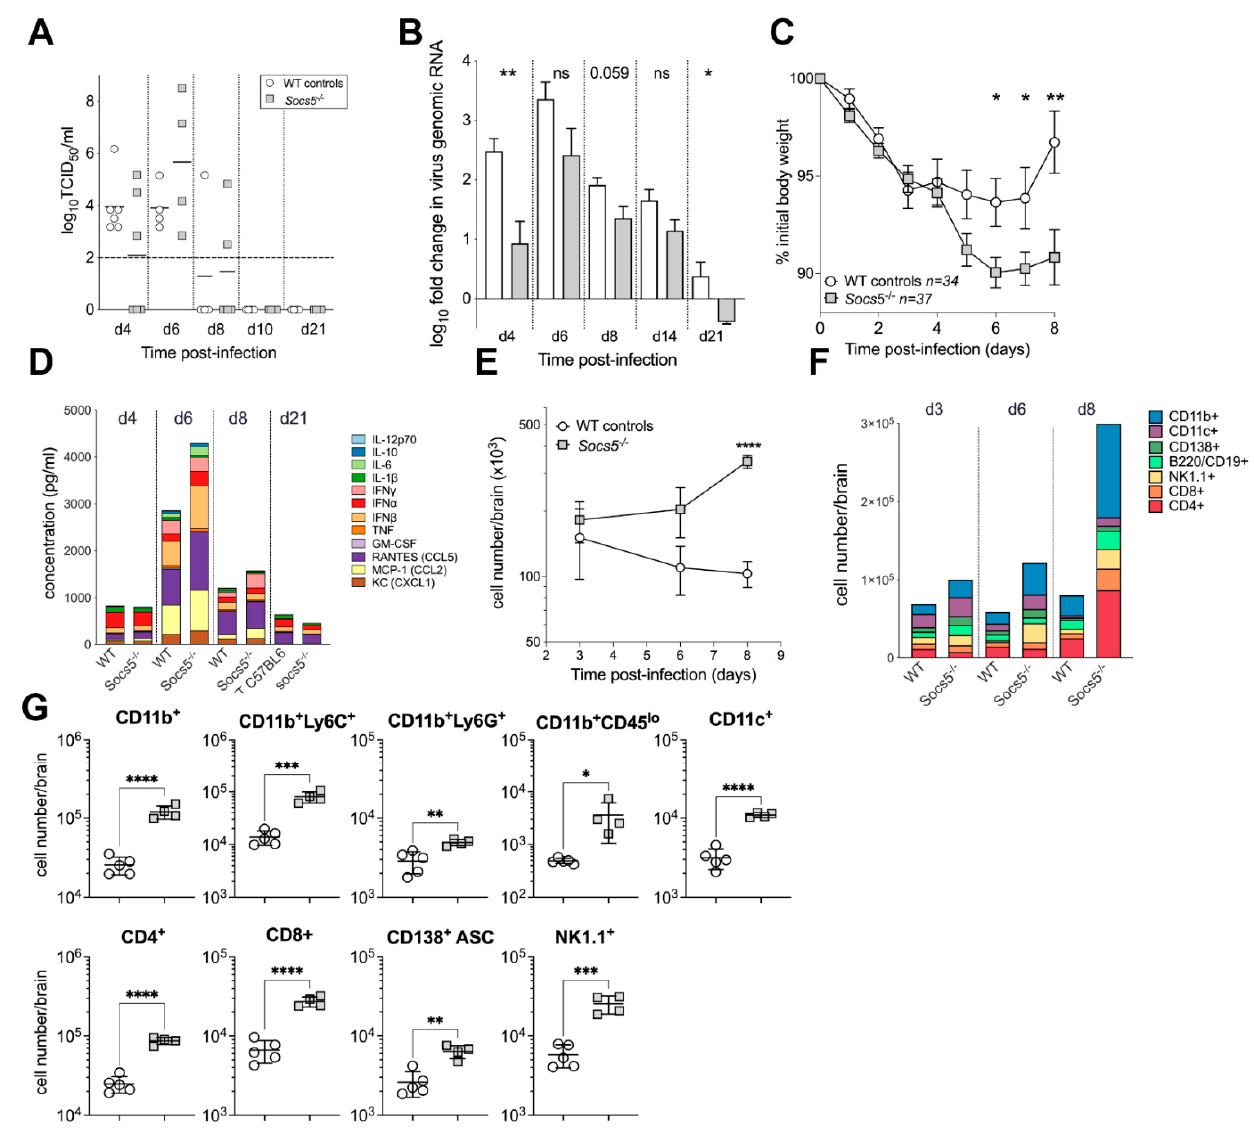
Figure 2 . SOCS5 deficiency exacerbates clinical disease and increases brain inflammatory responses.